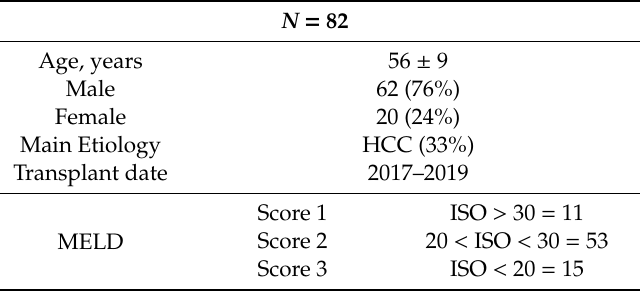
Table 1. Clinical and demographic